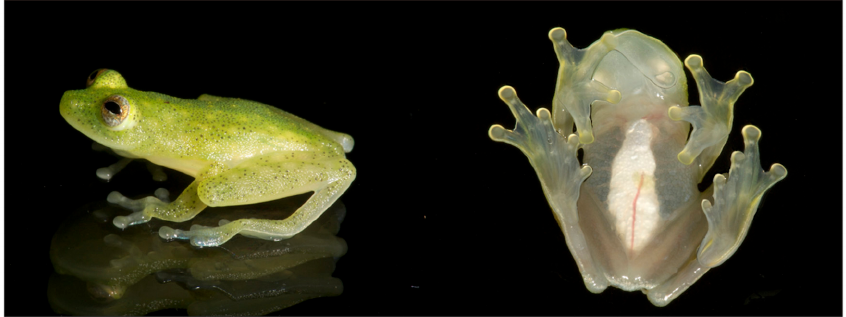
Figure 114. Hyalinobatrachium munozorum in life. Adult male from stream near Tena, 708 m, MZUTI 1616. Photos by Eduardo